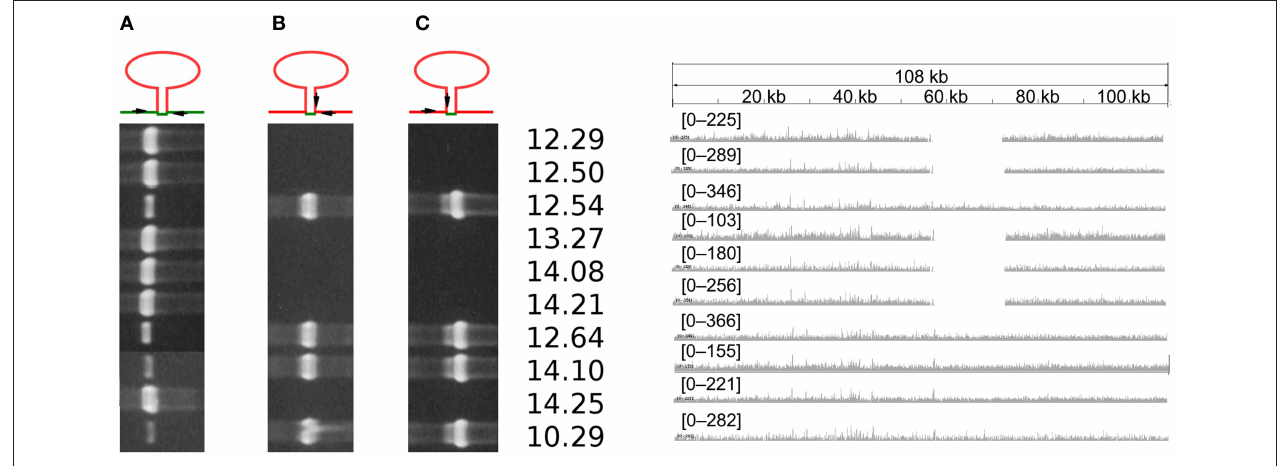
FIGURE 4 | Evidence of integration/excision of Tn6212. (Left) Agarose gels of PCR amplification products with (A) primers fX1/rX4 (686 bp) that amplify the chromosome region resulting from excision, (B) primers fX3/rX4 (739 bp) that amplify the downstream transposon junction, and (C) primers fX1/rX2 (933 bp) that amplify the upstream transposon junction, as indicated in the top scheme of PCR primers positions. (Right) Density of reads mapping on Tn6212 and flanking regions. The numbers indicate the CRAFRU strains.